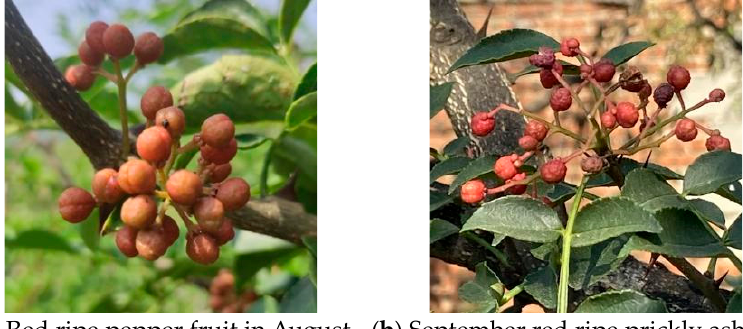
Figure 16. Comparison of red ripe prickly ash at di ff erent growth stages.